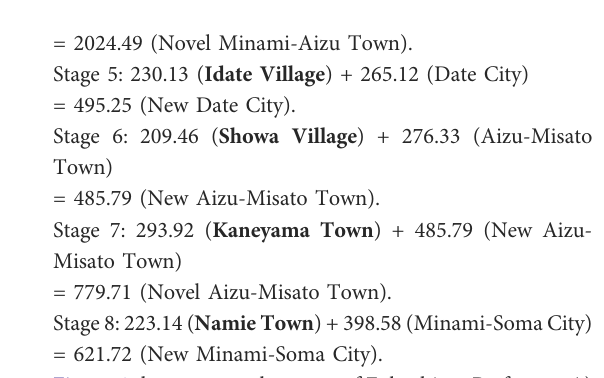
Figure 6 shows a complete map of Fukushima Prefecture A) before consolidation, B) under consolidations (Stage 4), and C) after consolidations (Stage 8). The pink dot on the east coast is marked to indicate the site of the Fukushima Daiichi nuclear power plant. In Figure 7A the dependence of the areas (km 2 ) of municipalities in this prefecture without consolidation is plotted as a function of the logarithmic rank. The blue declining line indicates the optimized fi t to Eq. 3 (| r | = 0.9938 with d = 0.851 for q = 0.75 and n = 59). Subsequently the dependence of the areas (km 2 ) of municipalities in the same prefecture under intermediate consolidations (Stage 4) is shown in Figure 7B. The blue line indicates the optimized fi t (| r | = 0.9783 with d = 0.532 for q = 0.59 and n = 55). Data of consolidated municipalities are highlighted with orange dots. The sigmoid seen in the high rank region is responsible for substantially reducing the degree of fi t, | r |, as well as the Durbin-Watson ratio d . Finally, for the complete consolidations (Stage 8) the dependence of the areas (km 2 ) of municipalities in the prefecture is shown in Figure 7C. The line indicates the optimized fi t to Eq. 3 (| r | = 0.9943 with d = 1.166 for q = 0.53 and n = 51). Data of consolidated municipalities are highlighted with orange and pink dots. It is found that the fi t to Eq. 3 recovers on the original one.